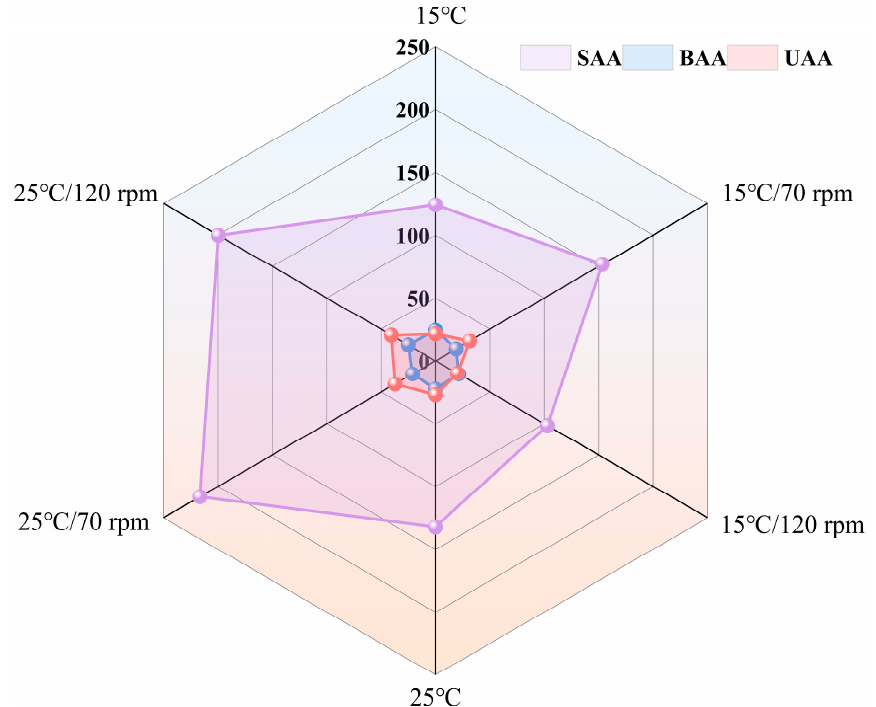
Figure 8. Changes in sweet amino acids (SAA), bitter amino acids (BAA), and umami amino acids (UAA) in grouper muscle during 24 h transport.